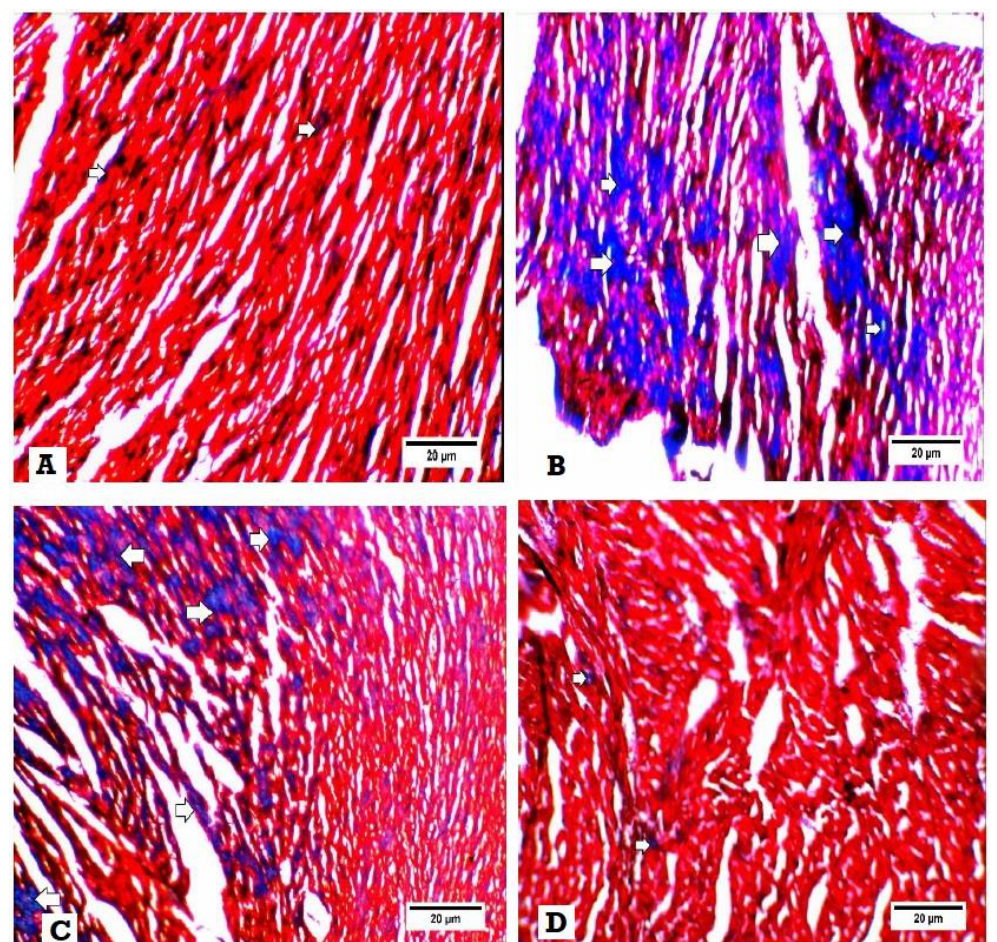
Figure 4. Histopathological examination for fibrosis by Masson trichrome. Interstitial fibrosis appears as blue colors. ( A ) Heart specimen from control group showing few interstitial fibrosis (400×), ( B ) heart specimen from the DM group showing marked interstitial fibrosis and collagen deposition (400×), ( C ) heart specimen from the DM + GLP1 group showing moderate interstitial fibrosis and collagen deposition (400x), and ( D ) heart specimen from the DM+ SGLT2i group showing minimal interstitial fibrosis and collagen deposition (400×).